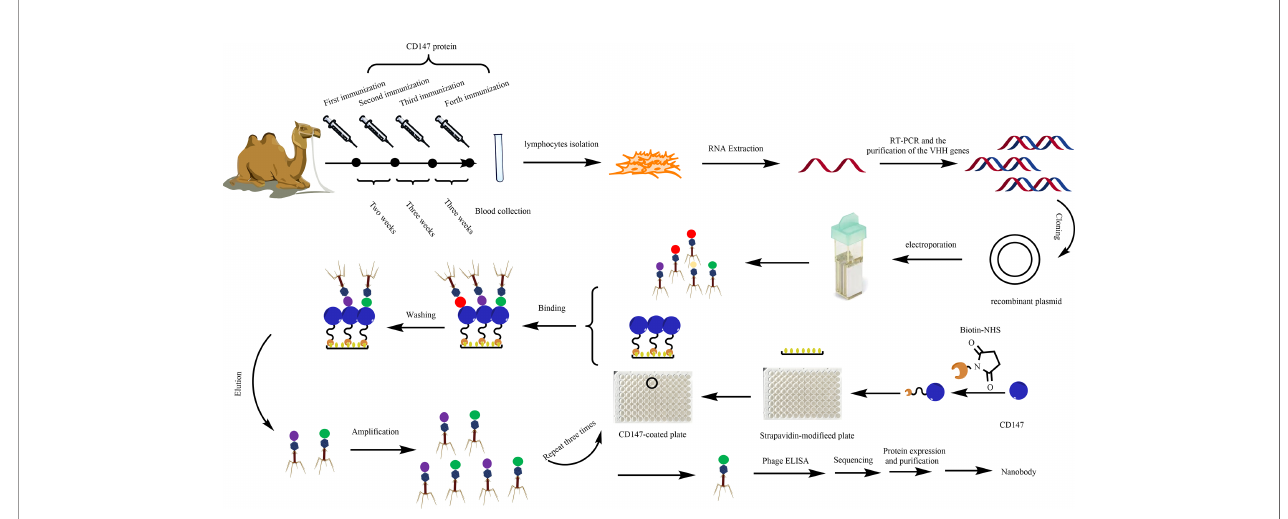
FIGURE 1 | Diagram of the strategies for anti-CD147-VHH library construction and the screening, expression, and puri fi cation of anti-CD147